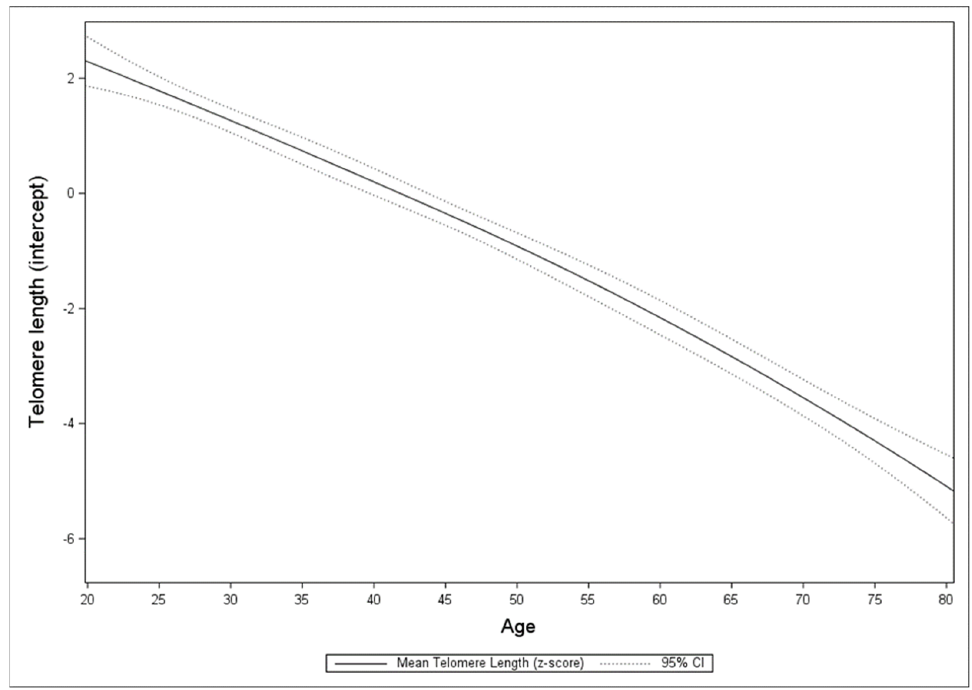
Figure 1. Mean telomere length intercept only model.